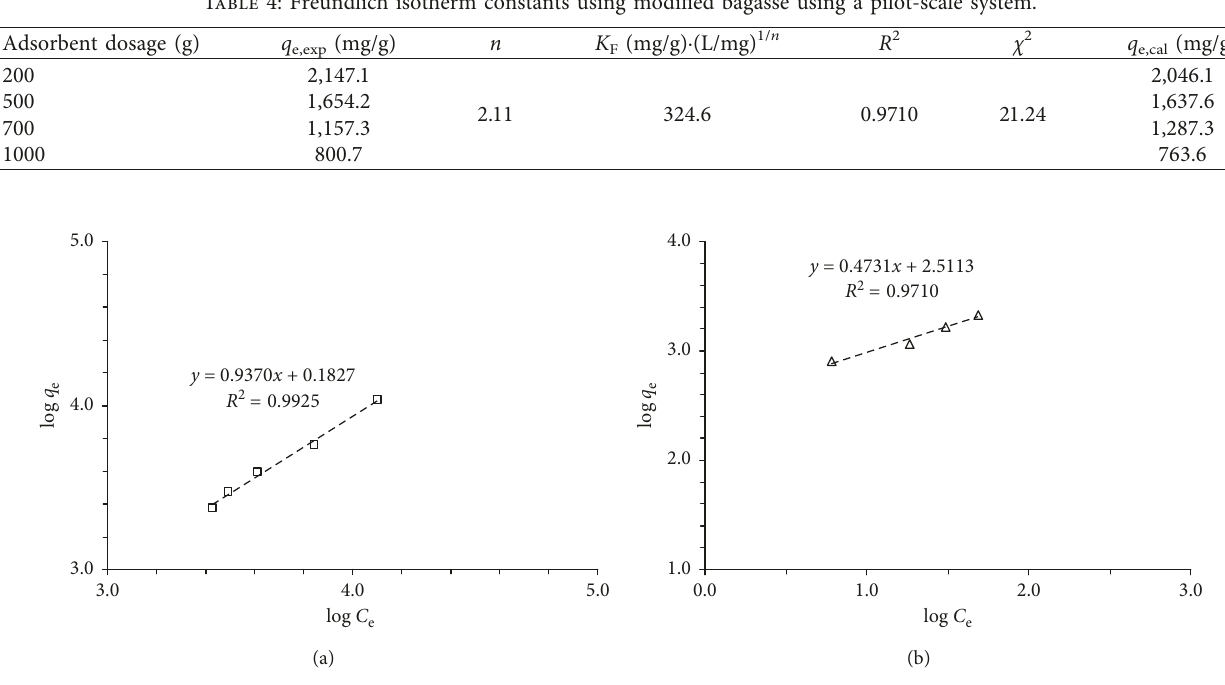
Figure 8: Freundlich isotherm plot using modified bagasse under (a) laboratory and (b) pilot scales. Table 5: Temkin isotherm constants using modified bagasse using a laboratory-scale system. Adsorbent dosage (g)